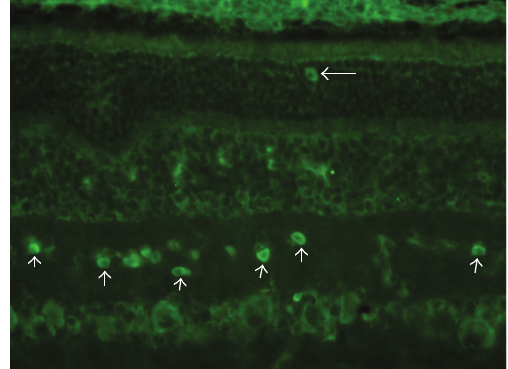
Figure 3: Xenografted human NPCs within the porcine retina. Donor cells were identified via anti-human nuclear immunola- beling and FITC-conjugated secondary (green). In addition to abundant cells within the subretinal space (top of image), labeled profiles were also evident within specific layers of the host retina, including the outer nuclear layer (horizontal arrow) and the inner plexiform layer (upward pointing arrows). In the latter case, the donor cells appear to be specifically positioned within a relatively restricted sublaminar zone. Survival = 12 days.